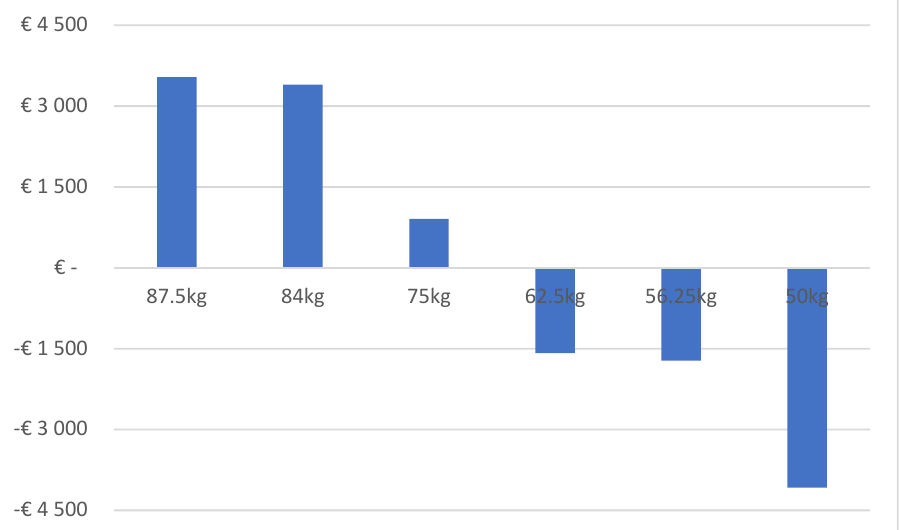
Figure 2. Difference in healthcare costs of 1 year course of adjuvant treatment with IV biosimilar trastuzumab as compared with SC reference trastuzumab.